Question: Looking at the figure, what chart type is it?
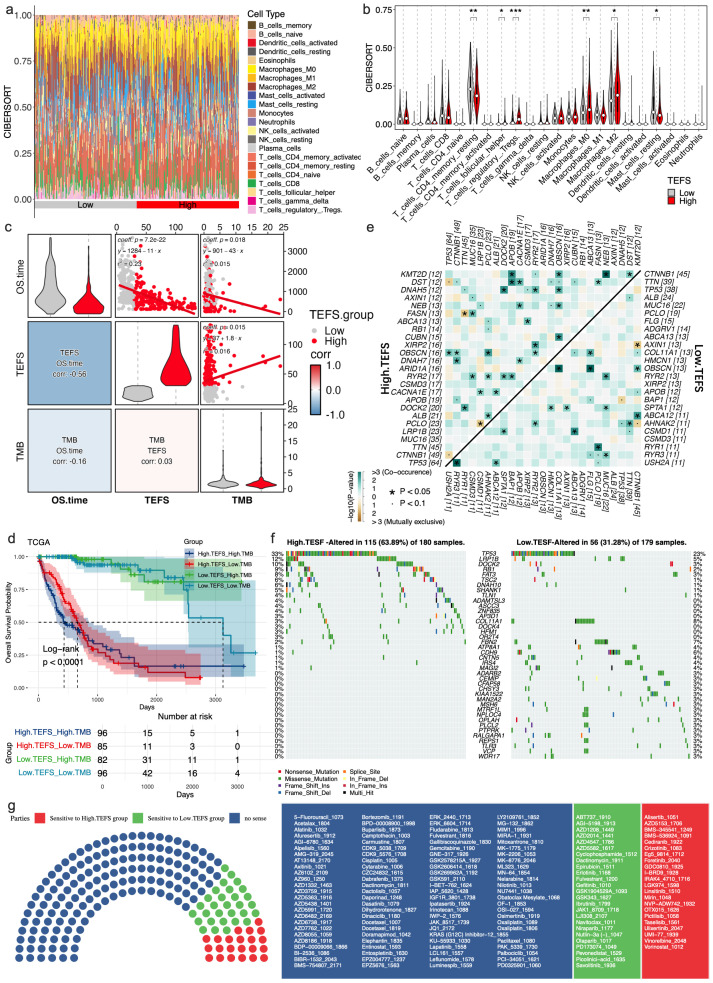
Answer: heatmap